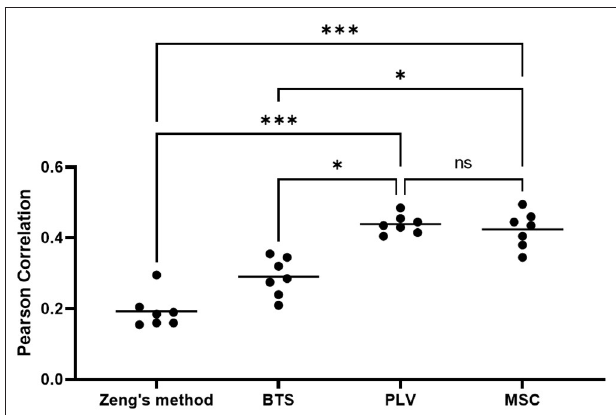
FIGURE 9 | The result of Friedman ANOVA test with FDR correction. Each dot indicates the average of PCC for each subject. The horizontal bars display